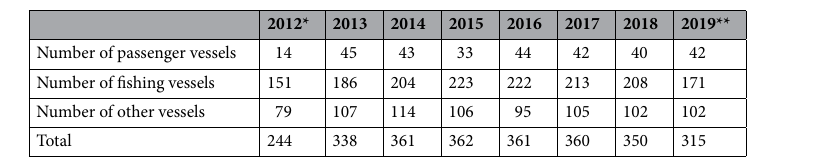
Table 1. The total number of unique vessels that sailed in the SFPZ per year. *August–December. ** January–